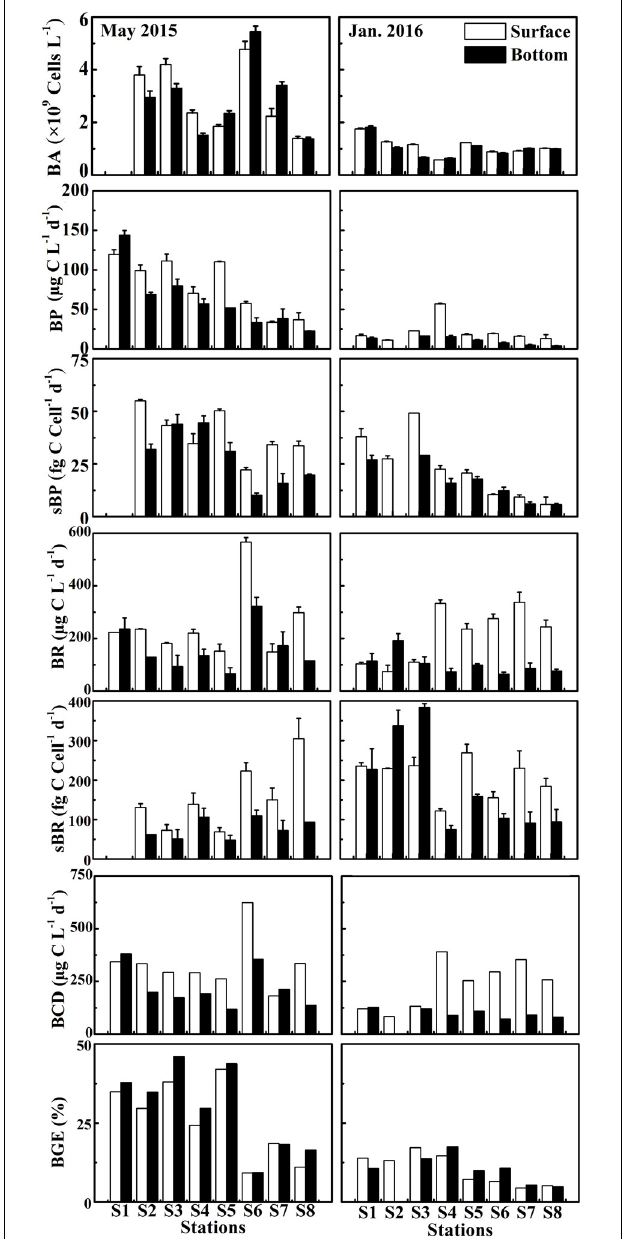
FIGURE 5 | Bacterial abundance (BA), bacterial production (BP), cell-specific bacterial production (sBP), bacterial respiration (BR), cell-specific bacterial respiration (sBR), bacterial carbon demand (BCD), and bacterial growth efficiency (BGE) at the surface and bottom at eight stations in the wet season (May 2015) and the dry season (January 2016).